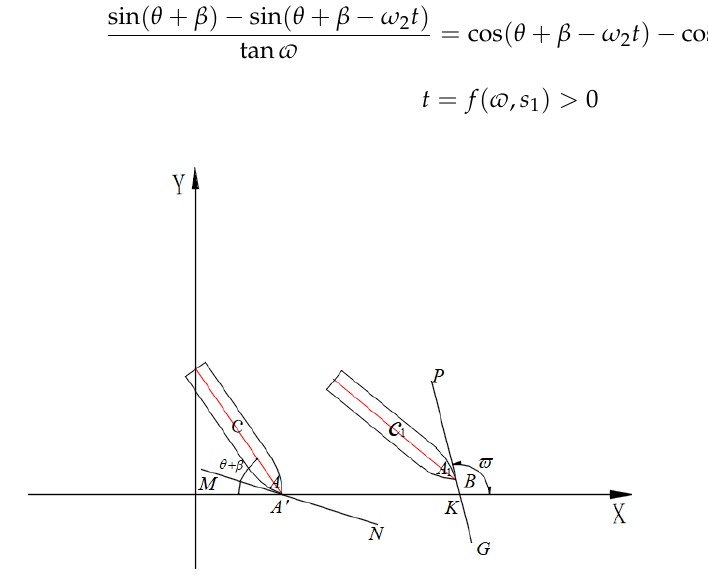
Figure 4. The diagram of a linear bulletproof structure.